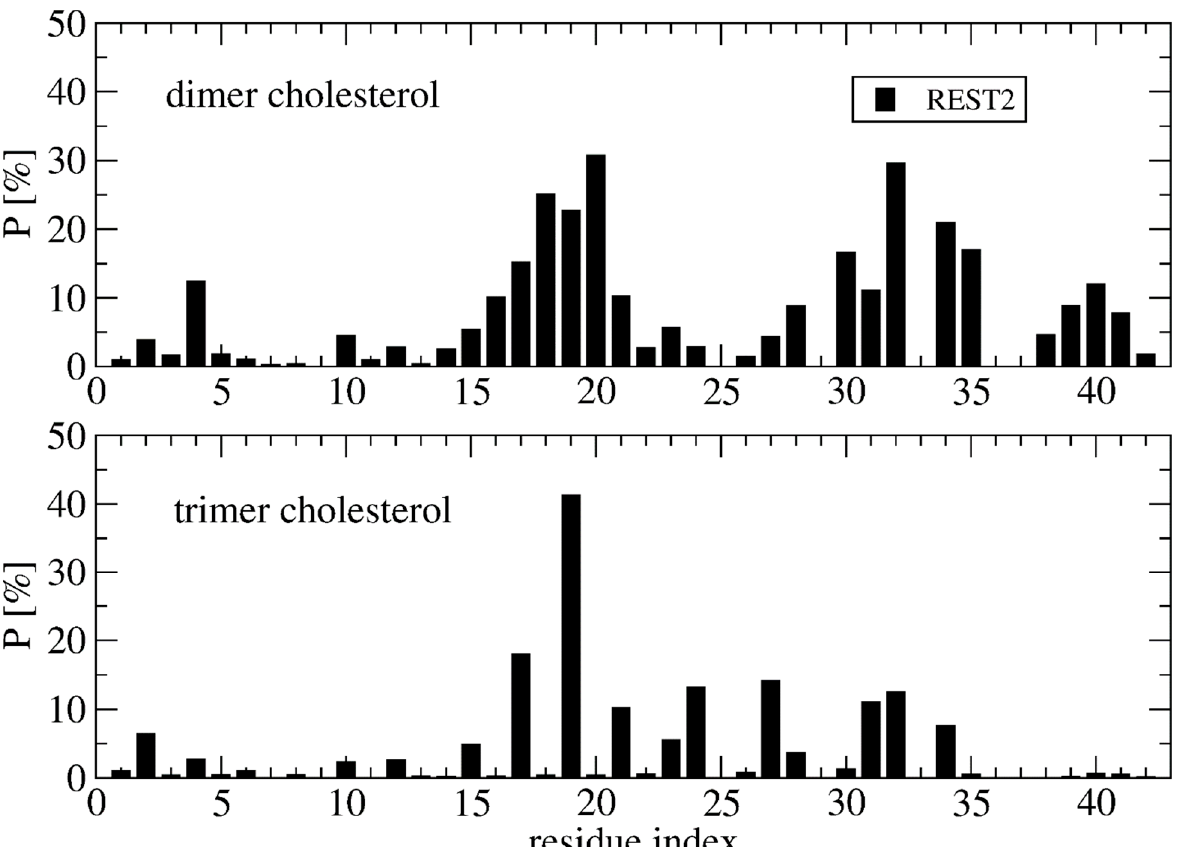
Figure 5. Probability of side-chain contacts between each cholesterol molecule and each amino acid of each A β 42 peptide using the time interval 50–250 ns of REMD at 315 K, and REST2 at 310 K.